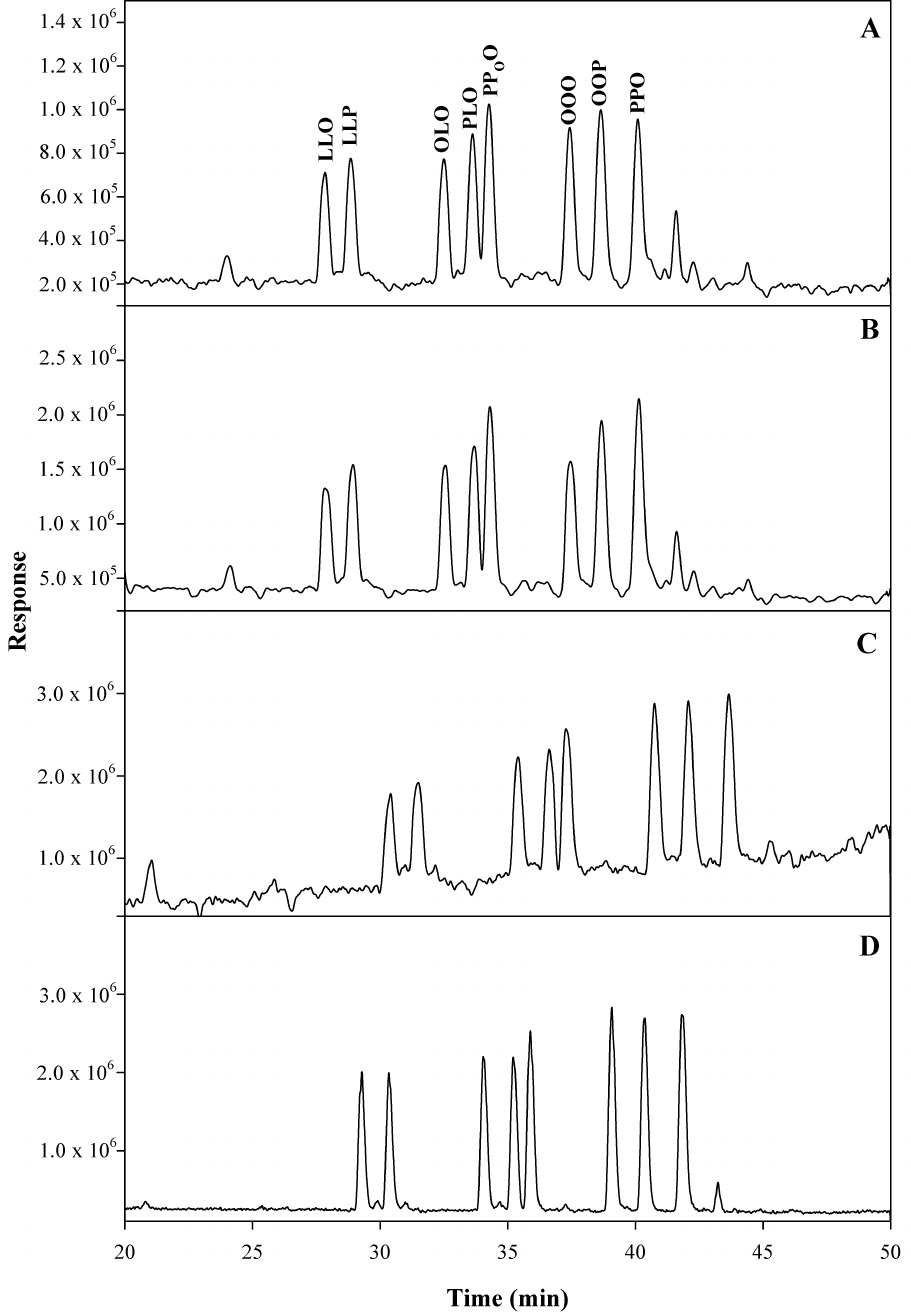
Figure 1. Total ion chromatograms of ( A ) APCI( + ), eluent: acetonitrile / isopropanol; ( B ) ESI( + ), eluent: acetonitrile / isopropanol; ( C ) ESI( + ), eluent: acetonitrile with 0.05% formic acid / isopropanol with 0.05% formic acid and 5 mM ammonium formate; ( D ) ESI( + ), eluent: acetonitrile with 0.1% water and 0.05% formic acid / isopropanol with 0.05% formic acid and 5 mM ammonium